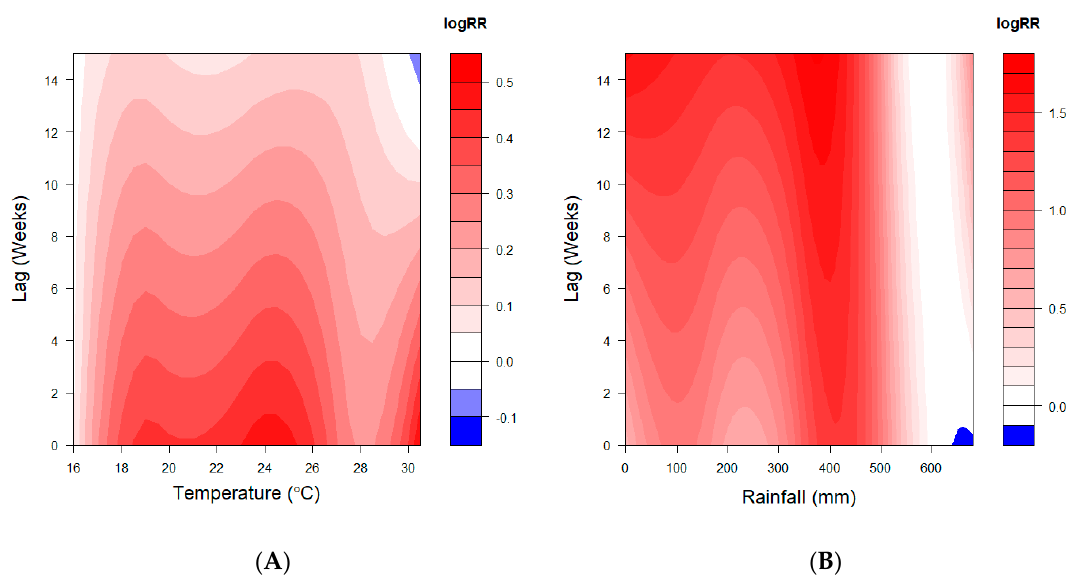
Figure 3. 3-D plot for relative risks (RR) of malaria disease along, ( A ) temperature, ( B ) rainfall, and lags produced by DLNM for all ages. The logRR are estimated with reference to 15.8 °C mean temperature and 609 mm of rainfall.